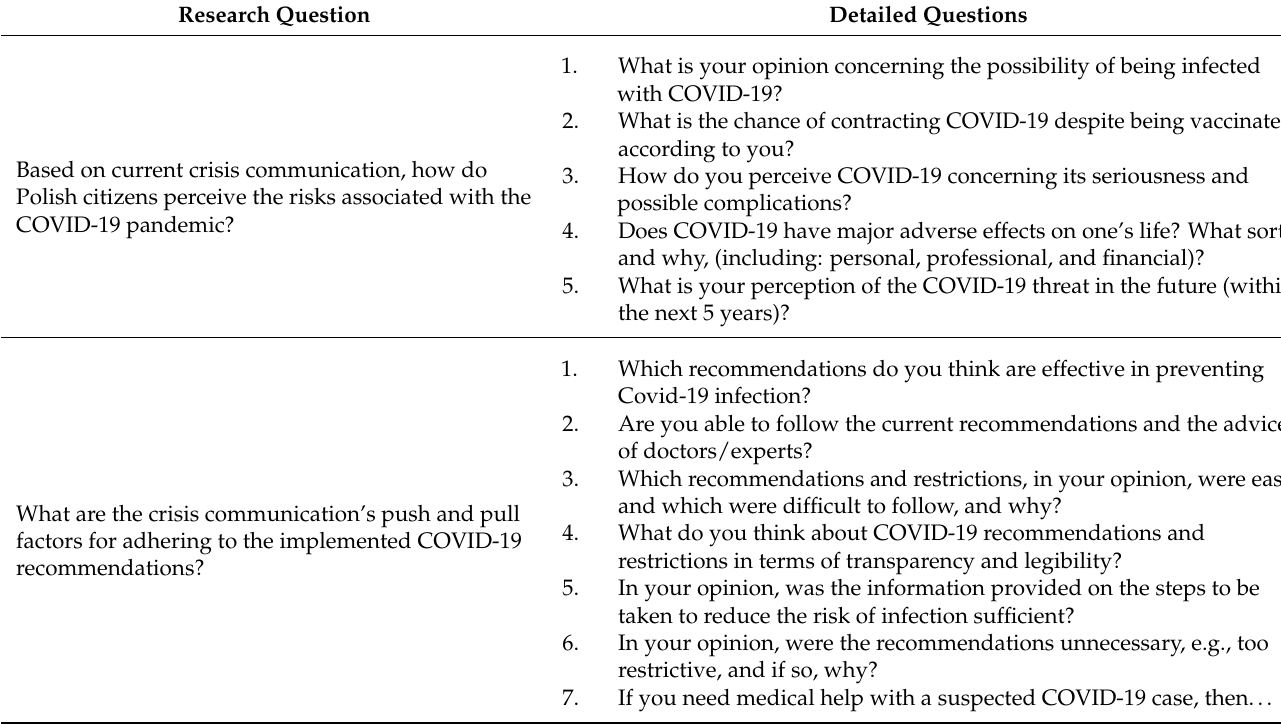
Table 1. Research questions and specific questions used in the FGDs